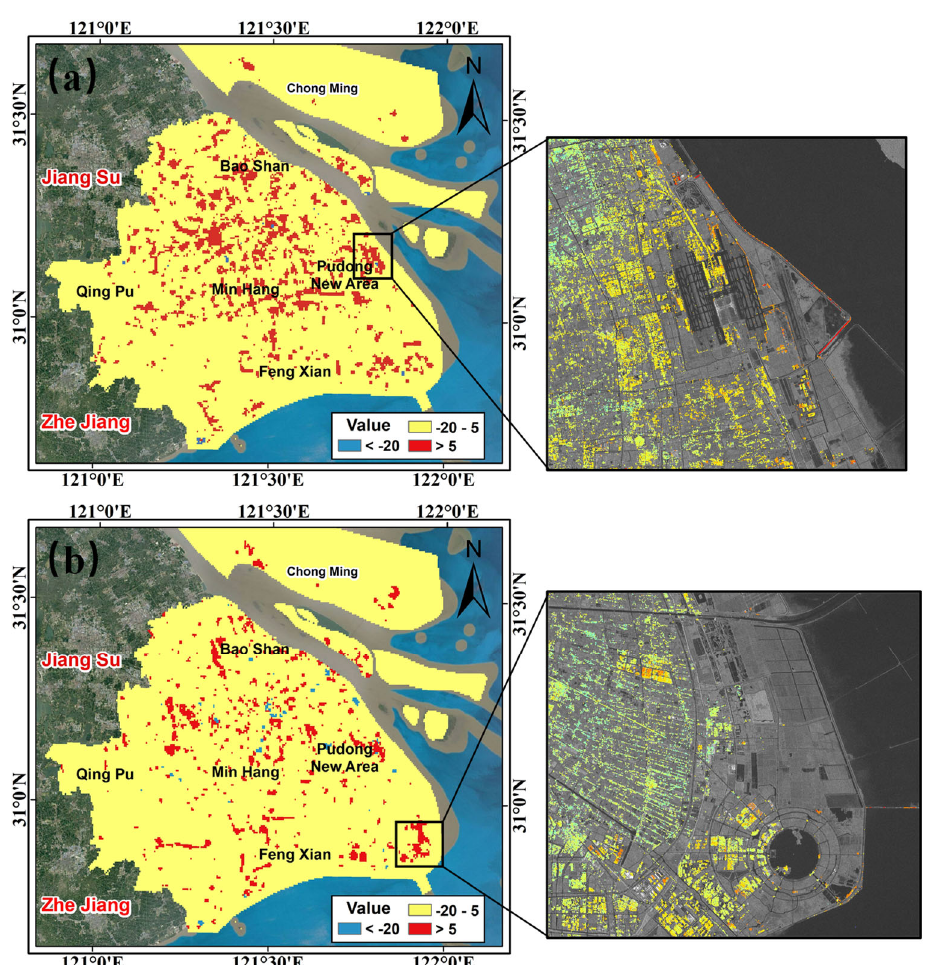
Figure 11. Here, ( a ) shows the change in nighttime light in the Shanghai area from 2016–2018; ( b ) shows the change in nighttime light in the Shanghai area from